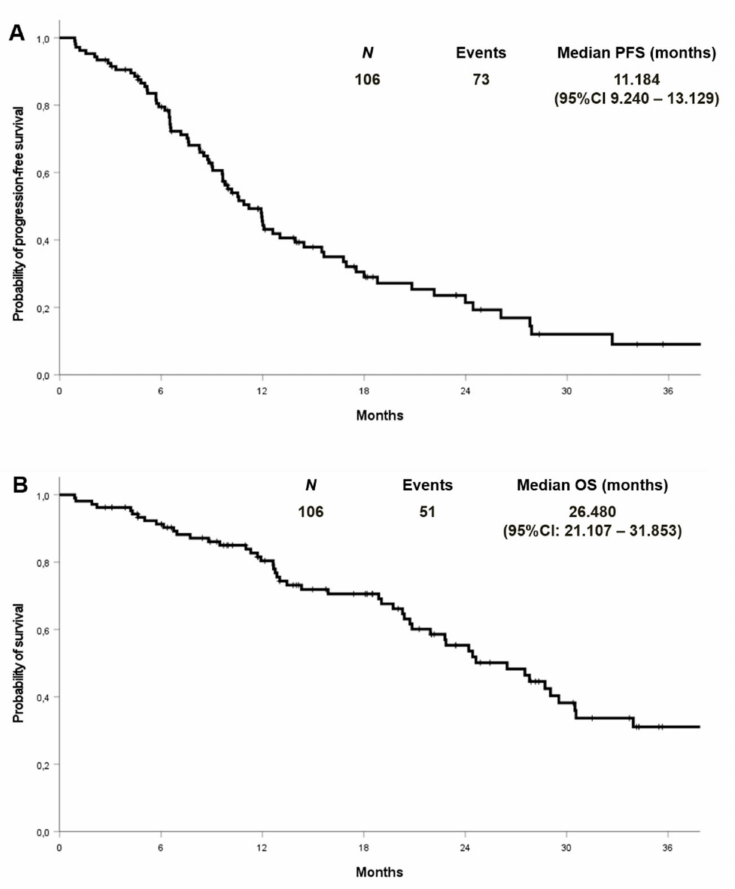
Figure 2. Progression-free survival ( A ) and overall survival ( B ) in patients with known co-mutational status.